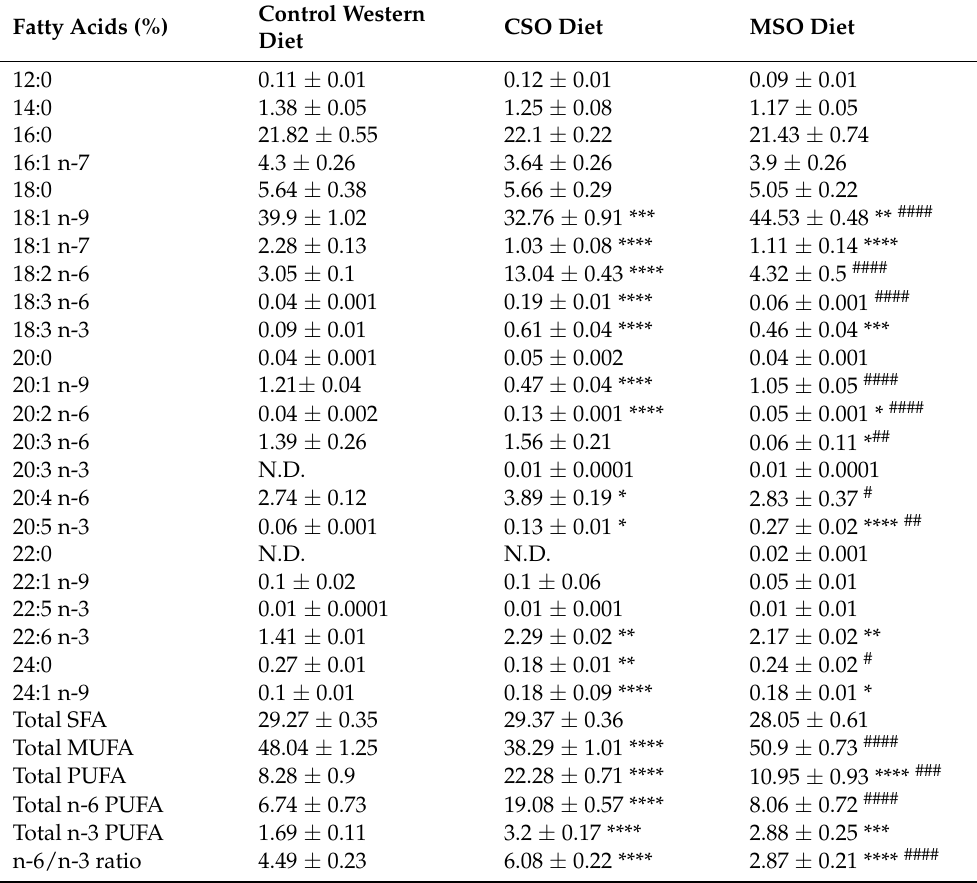
Table 1. Effect of CSO and MSO diets on hepatic fatty acid composition in LDLR-KO